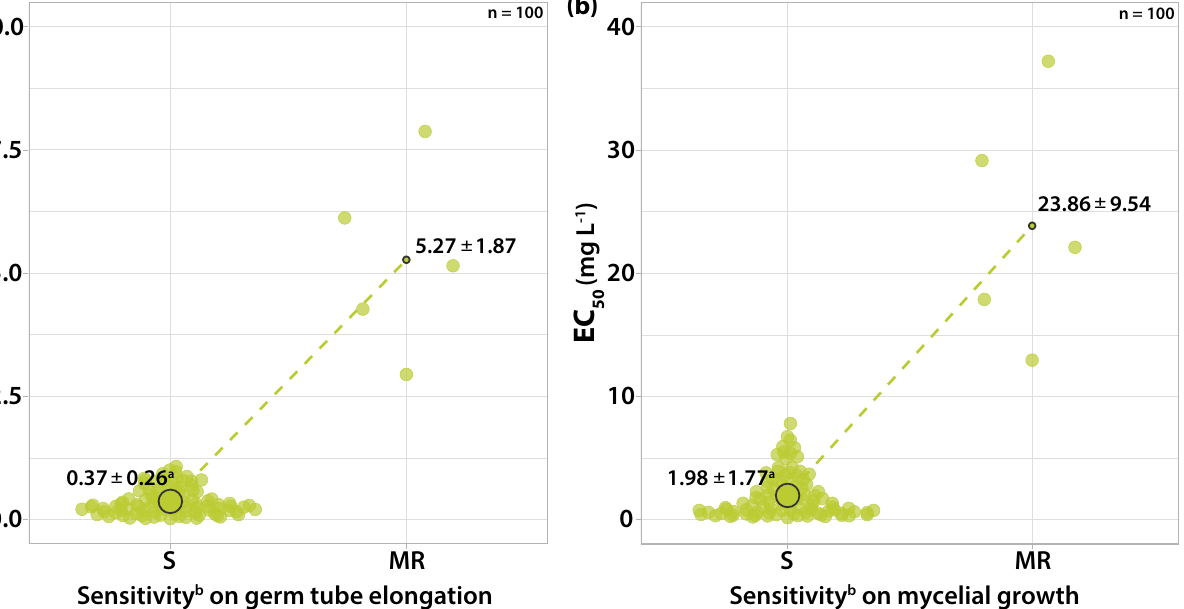
Figure 6. Frequency of sensitivity distribution for one hundred V. inaequalis isolates to boscalid on ( a ) germ tube elongation and ( b ) mycelial growth. The mean EC 50 values for the moderately resistant population of V. inaequalis were significantly higher ( p < 0.05) than the mean EC 50 val- ues of the sensitive population on both tests according to the Welch’s t -test. a Average values of sensitivity groups ± standard deviation; circle size reflects the population number. b Sensitivity groups: S, sensitive; MR, moderately